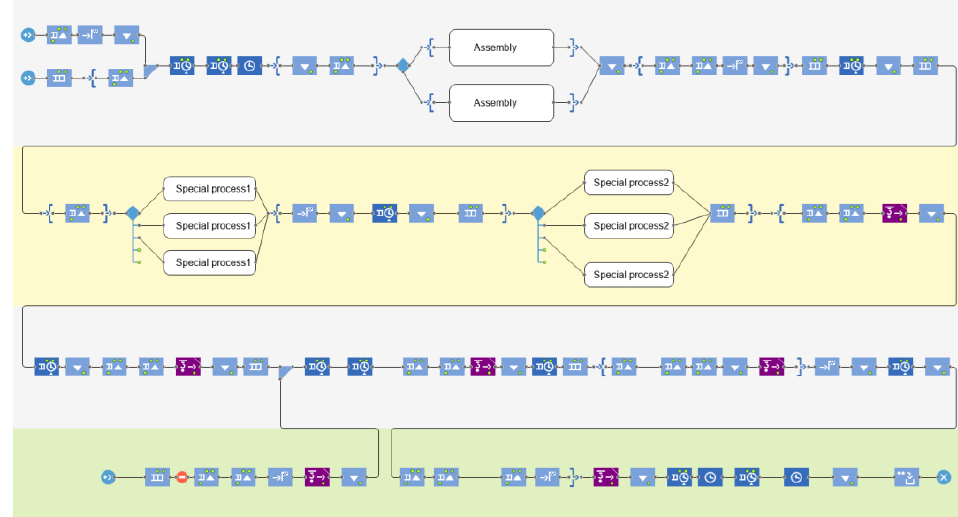
Figure 4. The simulation model of the general assembly line.